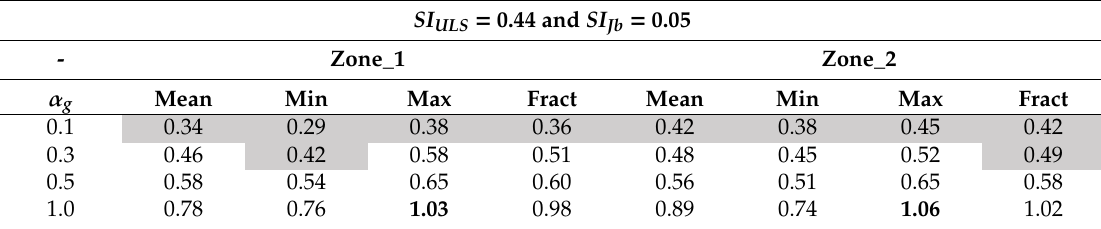
Table 5. Seismic performance according to the non-linear time history (NLTH) approach, maximum SI NLTH . SI ULS = 0.44 and SI Jb =